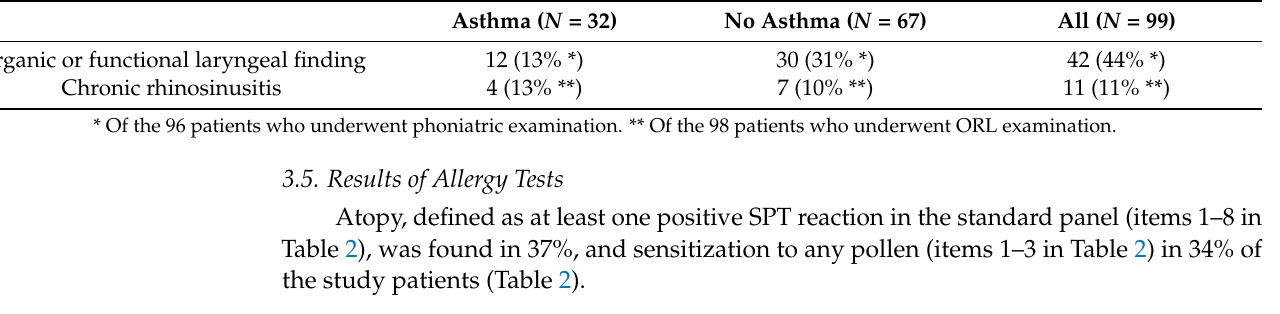
Table 2. Positive reactions to specific allergens in skin prick tests of study patients.